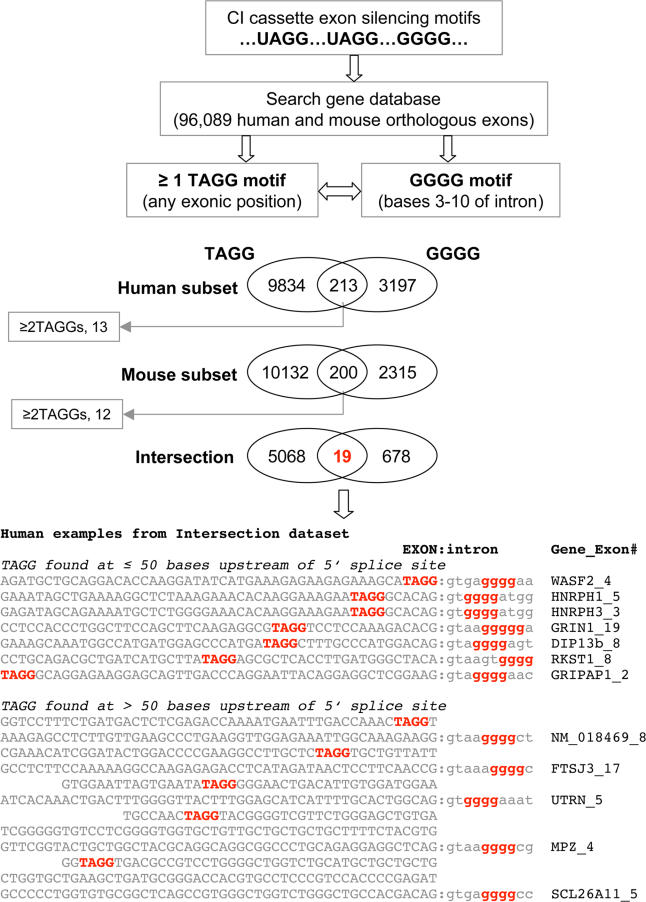
Genome-Wide Identification of Exons with UAGG and
GGGG Silencing Motifs
A database of 96,089 orthologous human and mouse exon pairs was searched for
TAGG located anywhere in the exon and
GGGG in bases 3–10 of the intron. Venn diagrams indicate the number of exons containing either or both sequence motifs in the human subset and the mouse subset of the database. The number of exons (19) in which UAGG and
GGGG silencer motifs are conserved in orthologous human and mouse exons is also shown (intersection). The motif patterns are shown in the context of the exon (uppercase) and 5′ splice site region (lowercase) for 12 examples from the intersection dataset (human sequences are shown). Colon indicates 5′ splice site. The conserved
TAGG and
GGGG motifs are highlighted in red to illustrate variations in their positions. Gene name (HUGO ID) and exon number within the gene are indicated at far right. For one uncharacterized transcript, the GenBank accession is given instead (NM_018469_8).